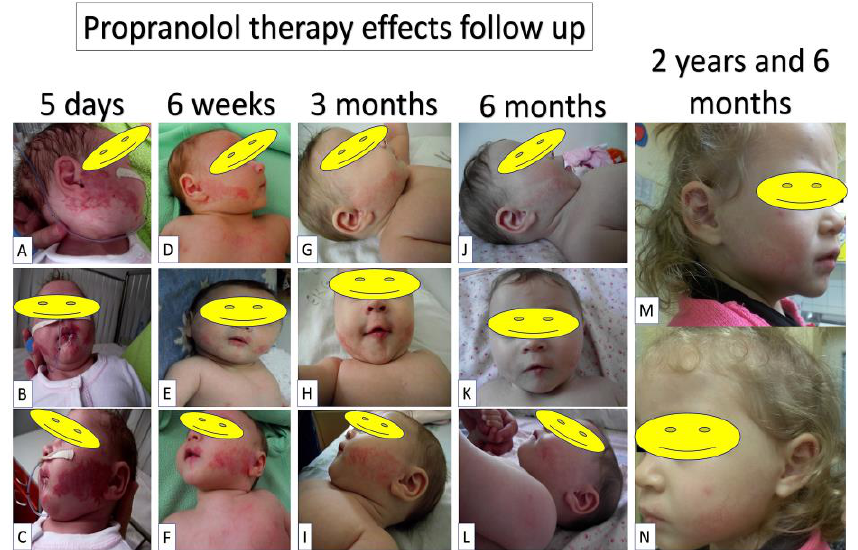
Figure 4. Extensive follow-up of facial hemangiomas regression as response to Propranolol therapy. After five days of therapy, the hemangiomas started to regress ( A – C ). Hemangioma regression continued and a reduced and paler area was observed at 6 weeks of therapy ( D – F ). After 3 months of therapy, lip hemangiomas were almost completely disappeared, and genian hemangiomas continued to regress ( G – I ). At 6 months, a high facial hemangioma regression continued to be observed ( J – L ). Therapy continued until 2 years of age. Six months after the end of Propranolol therapy, the facial hemangioma regression persisted and no recurrences were observed ( M , N